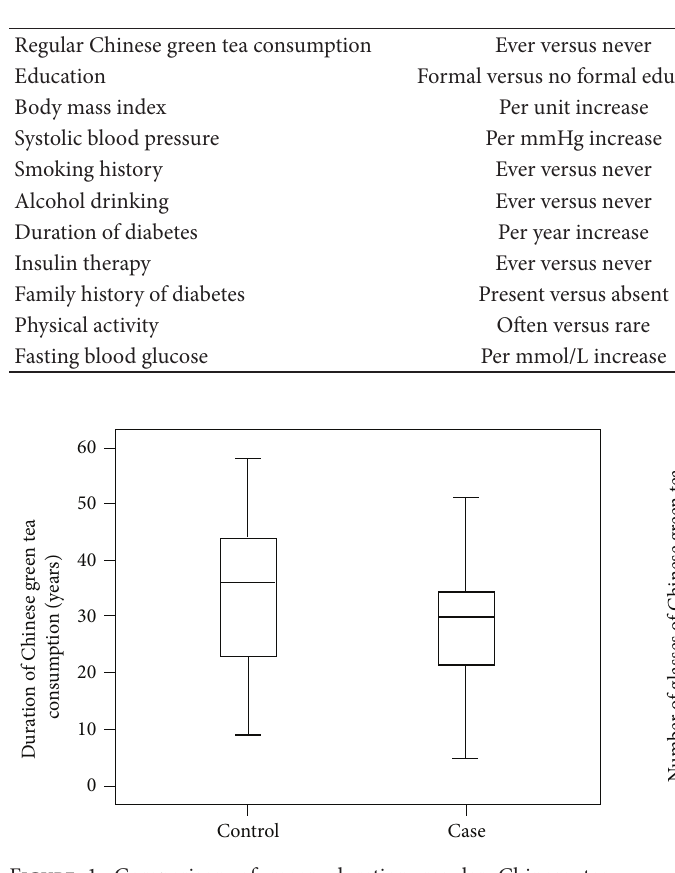
Figure 1: Comparison of mean duration regular Chinese tea consumption between the case and control group.